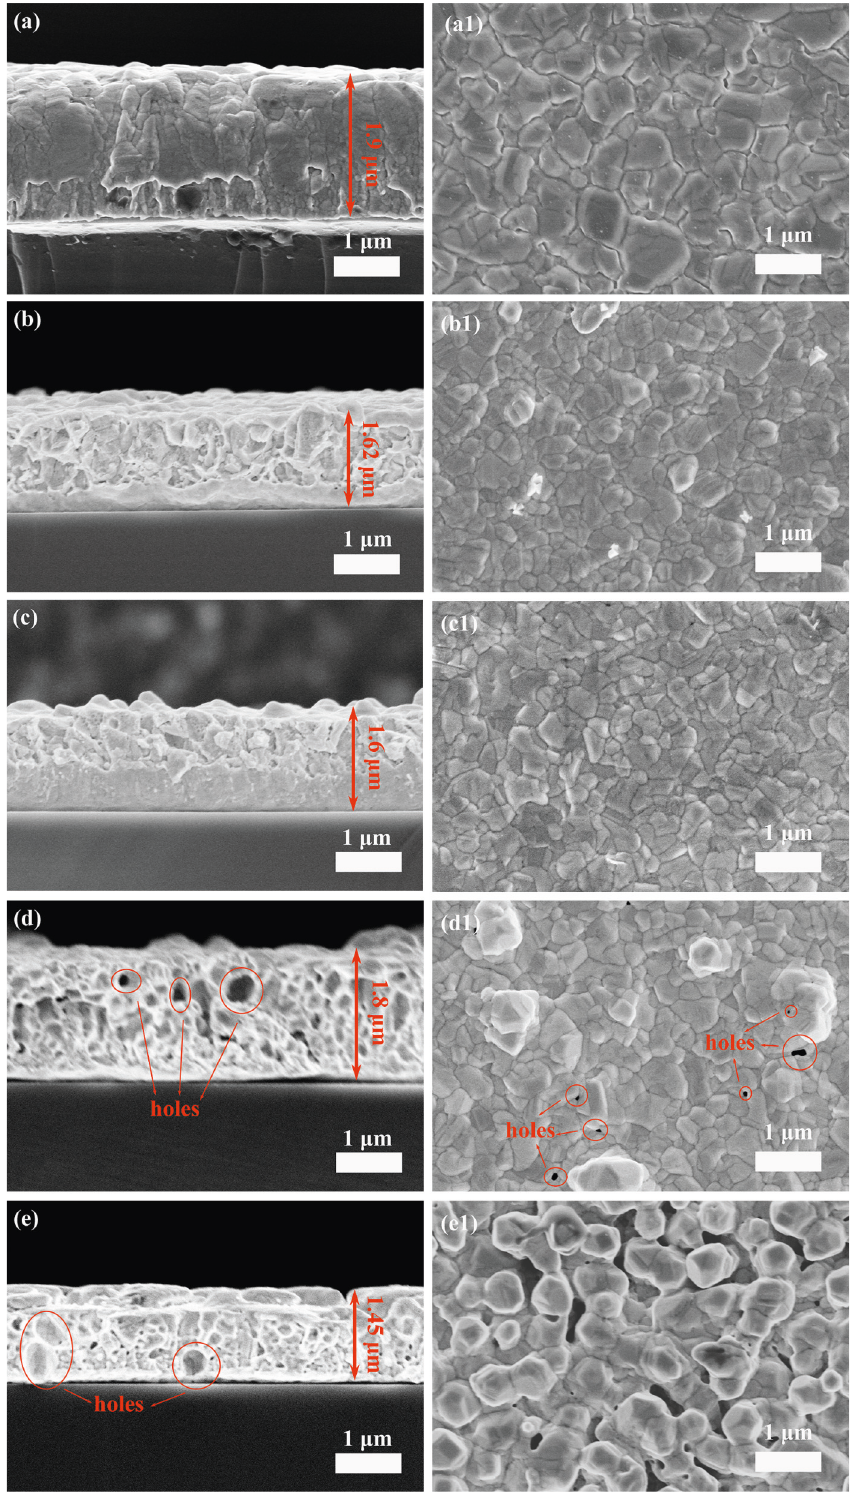
Figure 5: Surface and cross-sectional morphologies of S0, S12, S33, S50, and S100. (a), (b), (c), (d), and (e) show the cross-sectional morphologies of S0, S12,S33, S50,and S100, respectively.(a1), (b1), (c1), (d1),and (e1)show the surface morphologies of S0, S12,S33, S50,and S100,